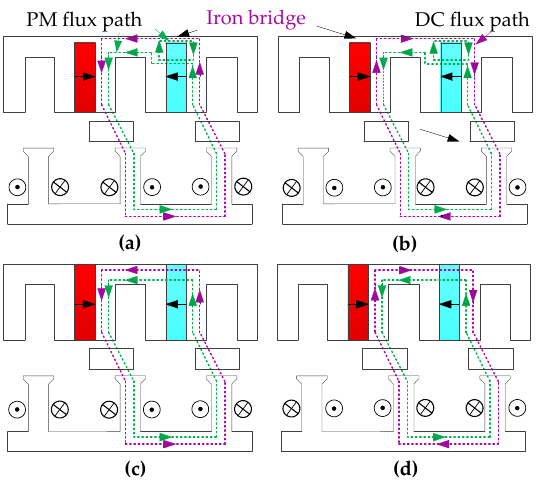
Figure 2 . Operation principle of PS-HEFS machine. ( a ) Flux enhancing, with iron bridges; ( b ) Flux weakening, with iron bridges; ( c ) Flux enhancing, without iron bridges; ( d ) Flux weakening, without iron bridges.